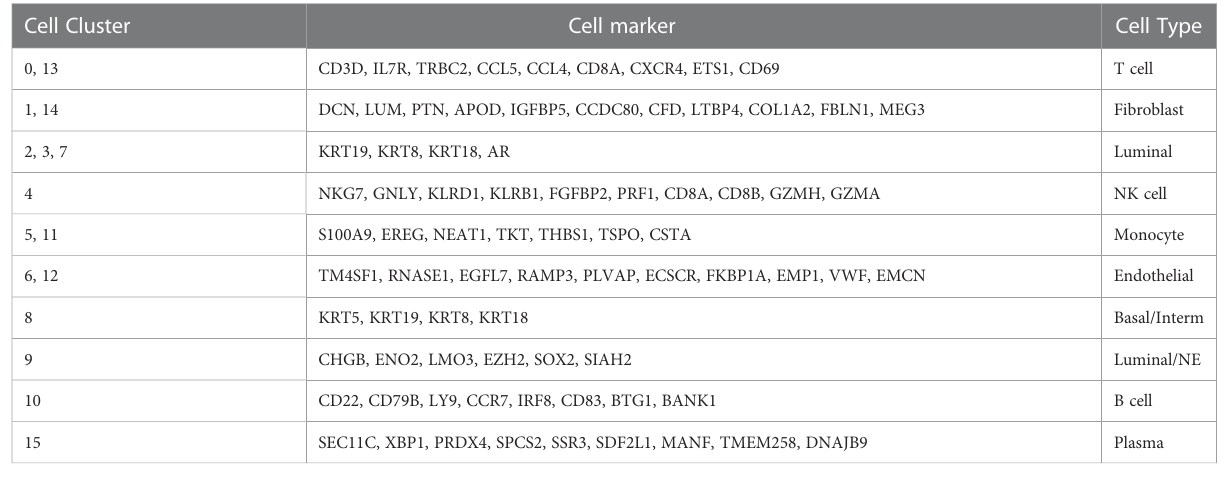
TABLE 2 Cell cluster distribution and cell marker.